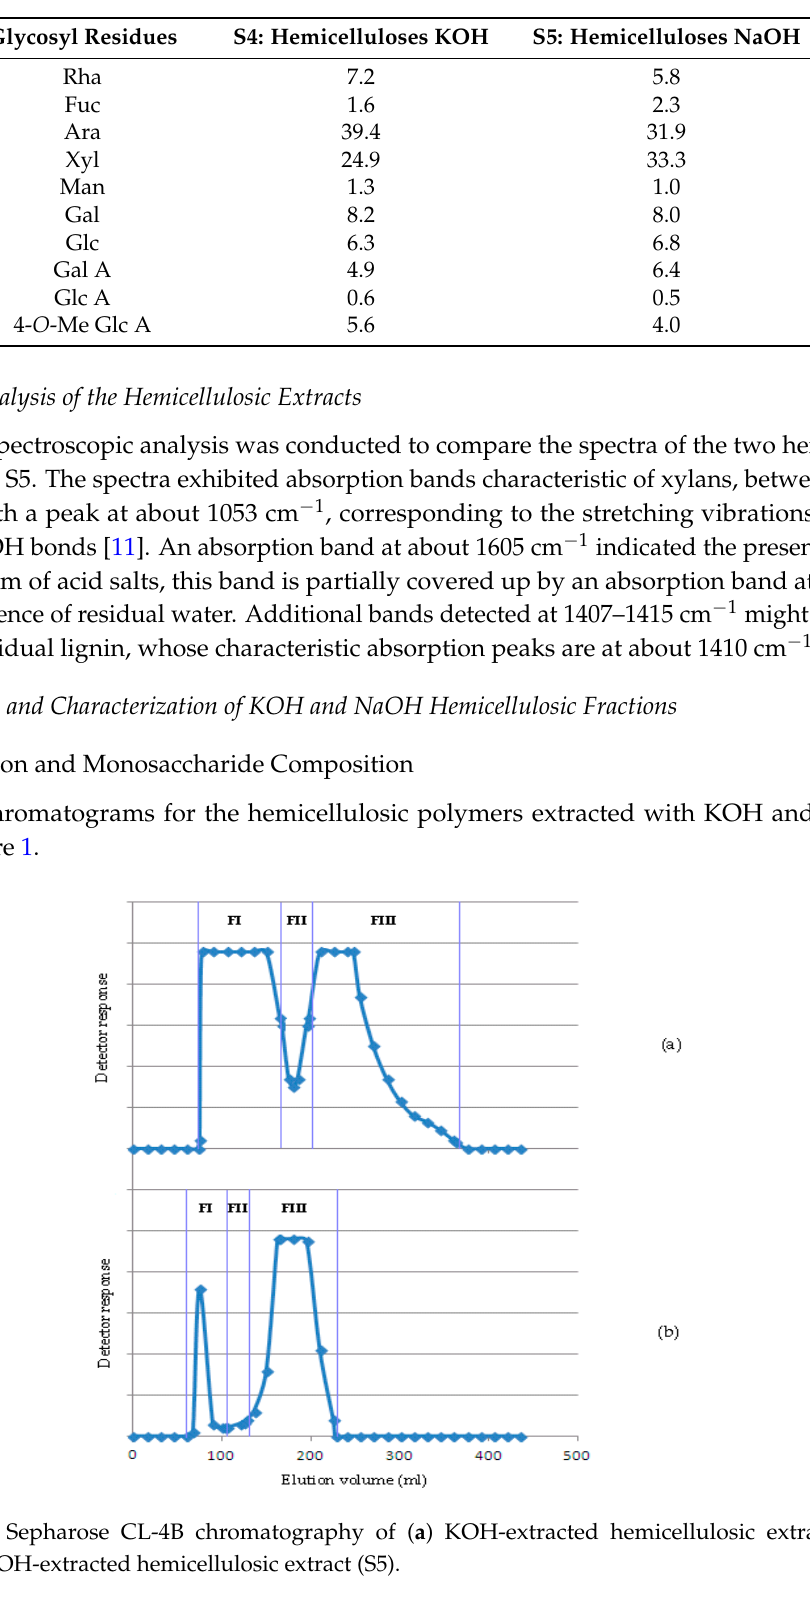
Table 2. Monosaccharide composition determined by gas–liquid chromatography (GLC) of hemicellulosic extracts isolated from A. spinosa.